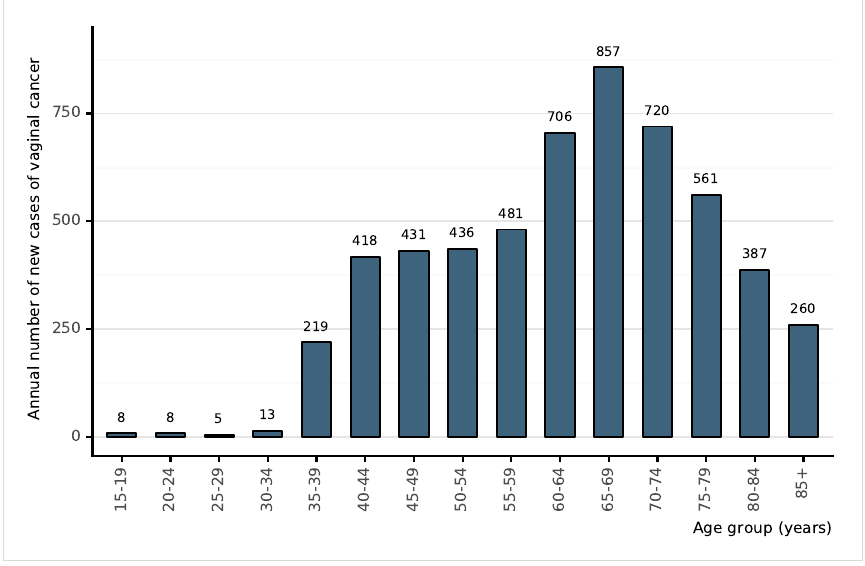
Figure 27: Annual number of new cases of vaginal cancer in India (estimates for